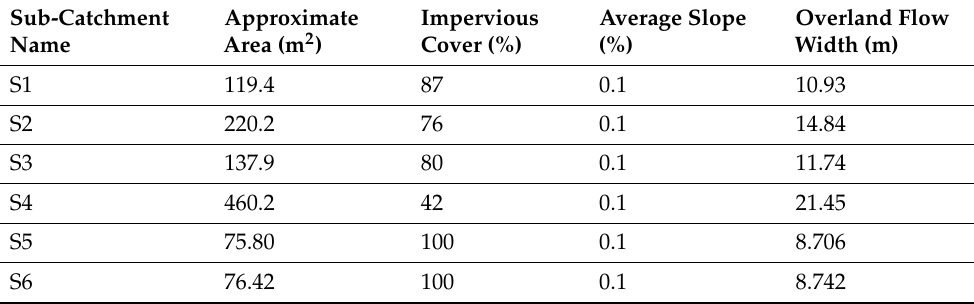
Figure 3. Location of the greenery, parking lot, and lawn area in the study site and the decentralized SWMM model. Table 1. Model characteristics of the study